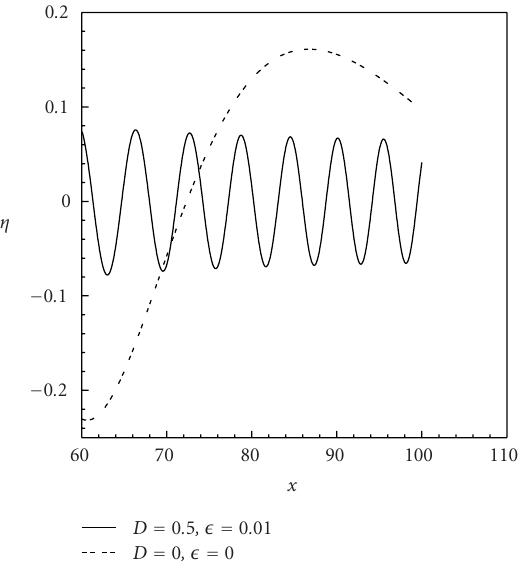
Figure 5.5. Wave motion due to initial displacement for fixed time t = 50; (cid:1) = 0 . 01, D = 0 . 5.